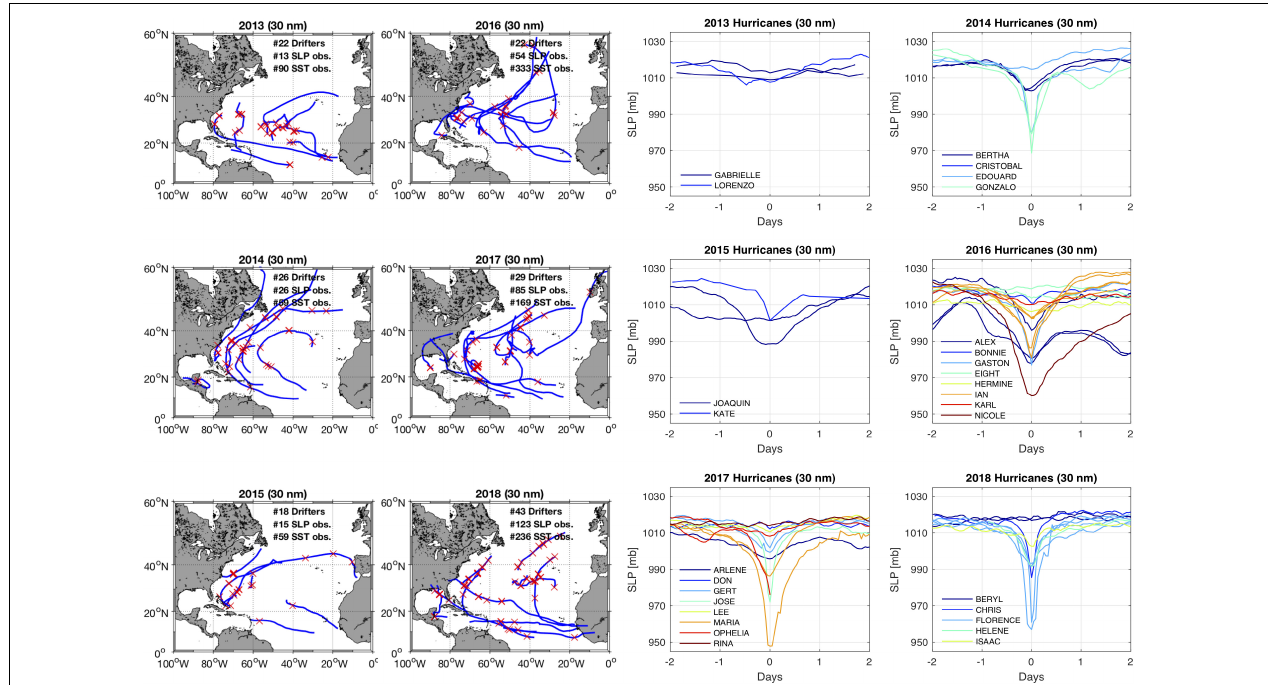
FIGURE 6 | Drifter/hurricane encounters (June 2013–September 2018). All drifter observations are within 60 min of the track location. Matches within 30 nm (left) are marked by red crosses. The hurricane tracks are shown in blue. For each hurricane season, the numbers of drifter/hurricane encounters are reported for each matching criterion as well as the total number of SST and SLP observations collected. Time series of SLP for drifter/hurricane matches selected using the 30-nm proximity criteria, color coded by storm name, are also shown. The time series are 4 days long and are centered around the minimum SLP pressure observed by the